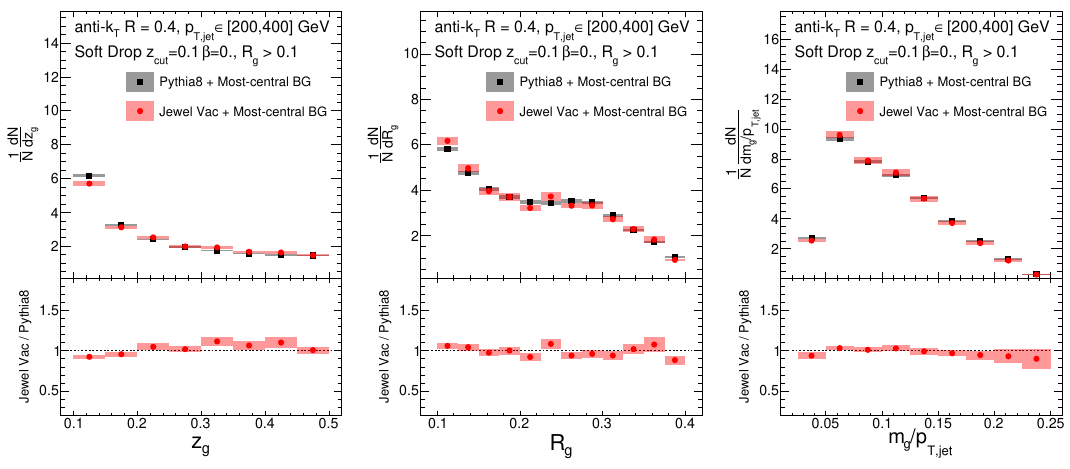
Figure 12 . Comparison on the substructure variables between two event generators: Jewel Vac- uum and Pythia8 , with the same embedding + subtraction procedures applied as those described in section